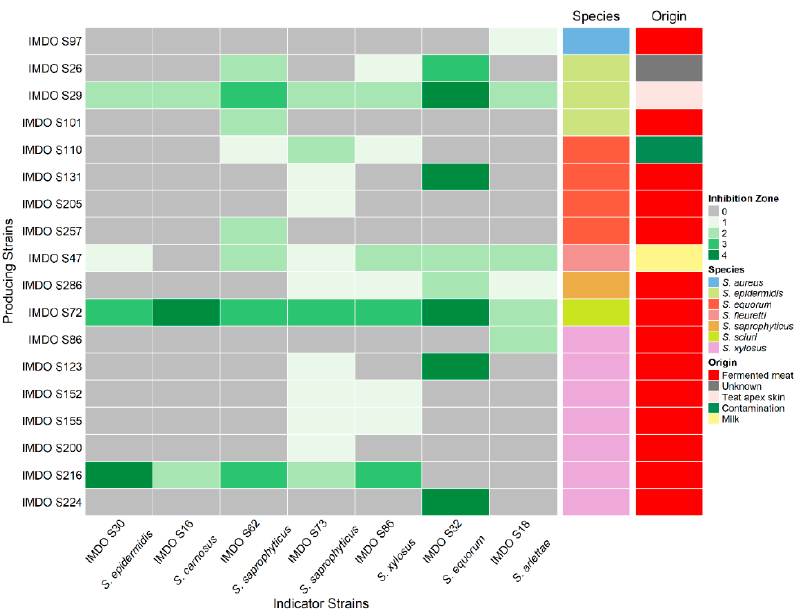
Figure 1. Heatmap of activity spectra of antibacterial Staphylococcus strains against seven indicator strains. The indicator strains used were isolated from different origins; IMDO-S30, fermented meat; IMDO-S16, fermented meat; IMDO-S62, teat apex skin; IMDO-S73, milk; IMDO-S86, fermented meat; IMDO-S32, teat apex skin; and IMDO-S18, teat apex skin. On the right side, species and origin of the producing strains are represented. Producing strains are ordered alphabetically according to species name.